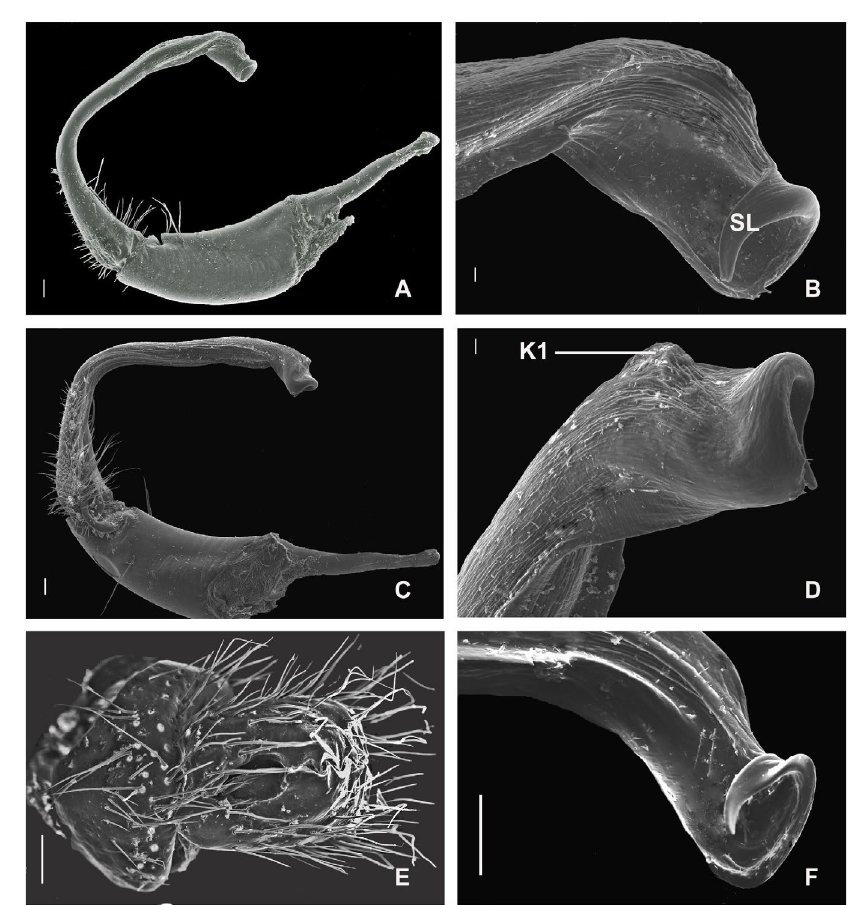
Fig. 10. Levizonus thaumasius Attems, 1898, ♂♂, ♀ (FSCB 12007, 12016). A . Gonopod, lateral view. B . Gonopod apex, lateral view. C . Gonopod, mesal view. D . Gonopod apex, mesal view. E . Vulva, mesal view. F . Gonopod apex, lateral view. Scale bars: A = 200 μm; C, E–F = 100 μm; B, D = 20 μm.